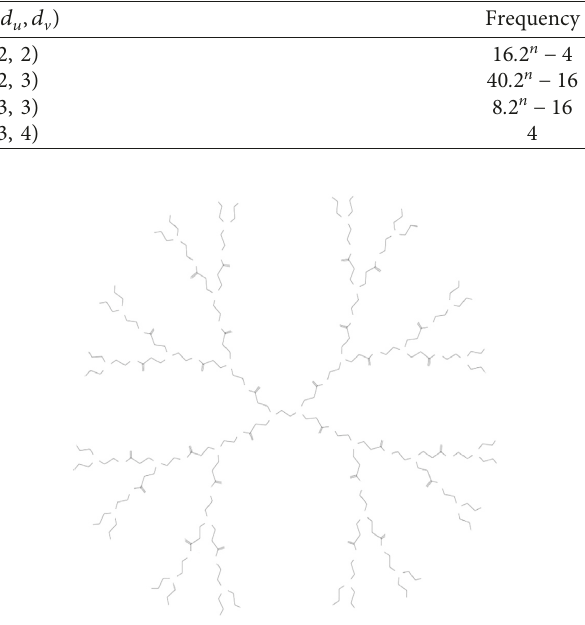
Figure 4: Poly(EThylene Amide Amine) Dendrimer. Table 4: Degree-based edge partition of PETAA, of end vertices of each